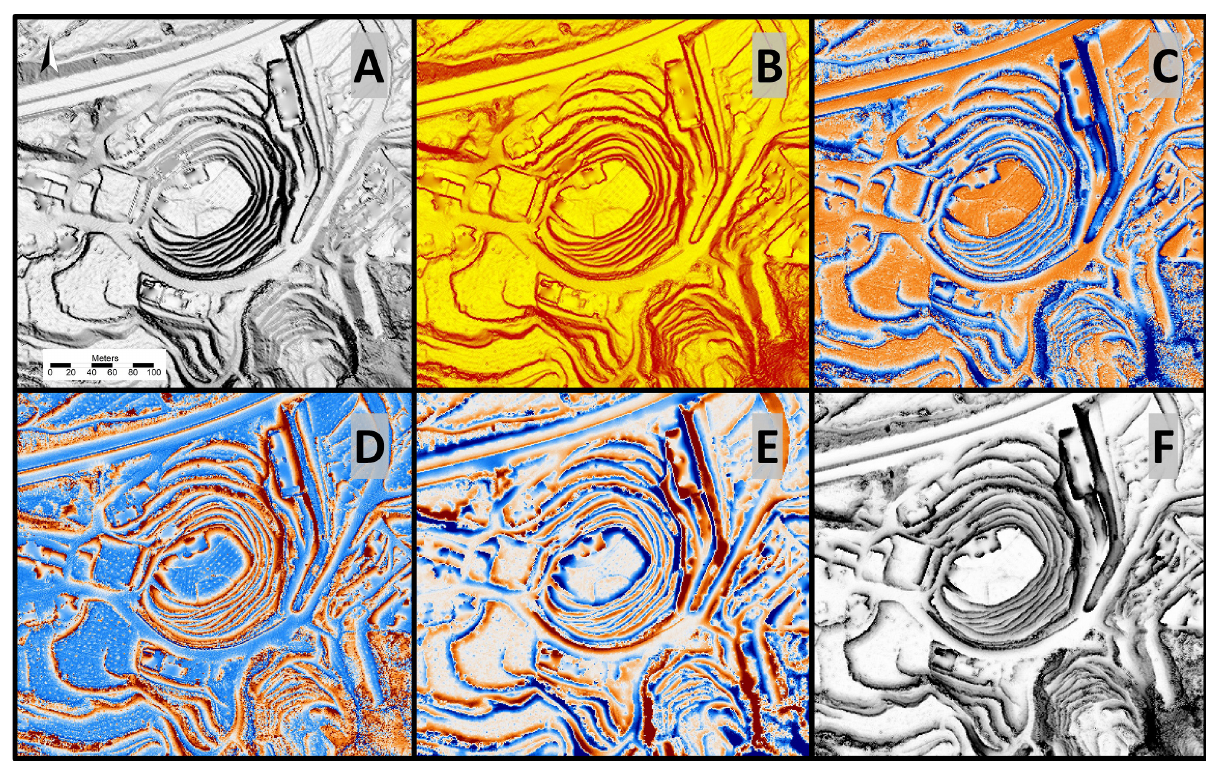
Figure 6: Applied visualization methods on the example of Tell el-Heri. A) Hillshade (Combined Shading). B) Slope map. C) Positive Openness. D) Negative Openness. E) Local Relief Model. F) Sky View